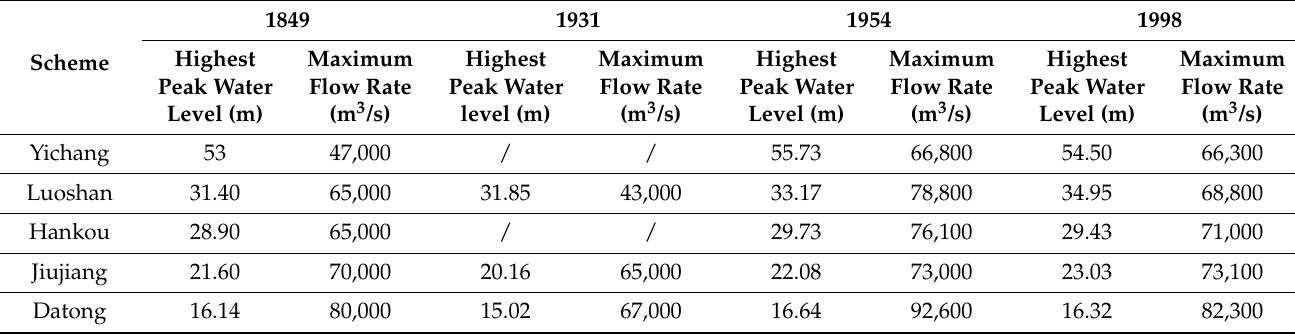
Figure 5. Maps of droughts and floods in summer of the Yangtze River Basin in several great flood years. 1: severe drought, 2: drought, 3: normal, 4: flood, 5: severe flood. Table 3. Comparison of flood peak flow rates of four flood years in the Yangtze